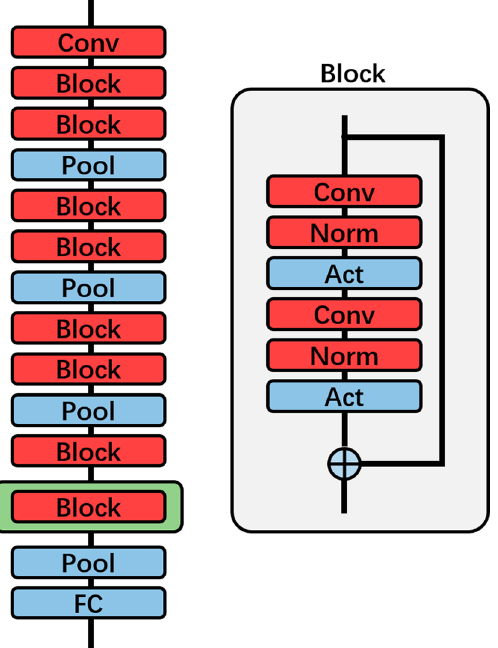
Fig. 1 Illustration of the ResNet-18 architecture and its memory requirements. Modules contributing to the peak memory consumption are shown in red. These modules contribute to the memory cost by storing their input in memory. The green annotation represents the extra memory cost of storing the gradient in memory. The peak memory consumption happens in the backward pass through the last convolution so that this layer is annotated with an additional gradient memory cost. At this step of the computation, all lower parameterized layers have stored their input in memory, which constitutes the memory